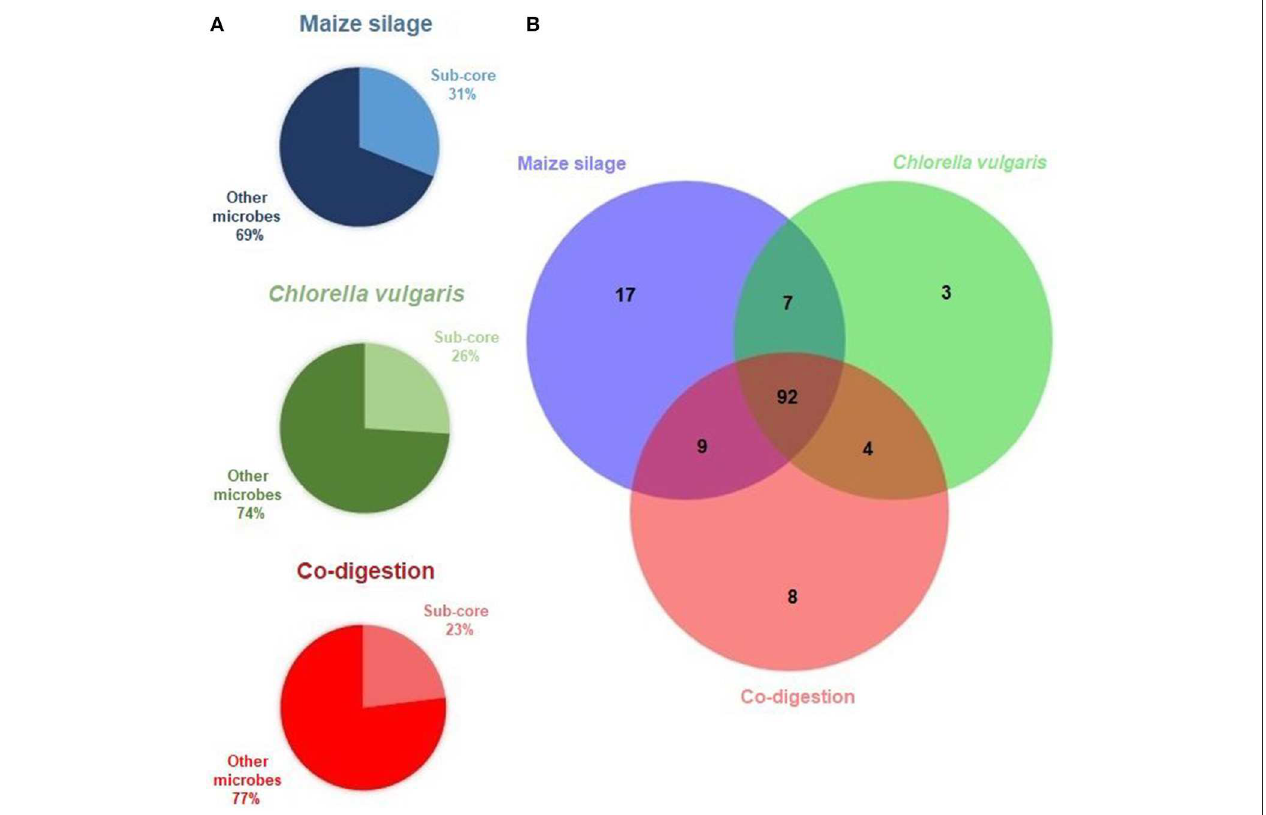
FIGURE 2 | The results of core microbiome calculation. (A) The Venn diagram presents the sub-core habitat associations within the anaerobic digesters. The sub-cores, i.e., genera present at the 6 sampling times are included in the diagram, and in the intersection of the sub-cores representing the core, i.e., genera shared among all samples. (B) Sub-cores: taxa shared in the communities of the specific feedstock digestion at all 6 time points. Other microbes: genera present in some but not in all 6 samples of the given feedstock.